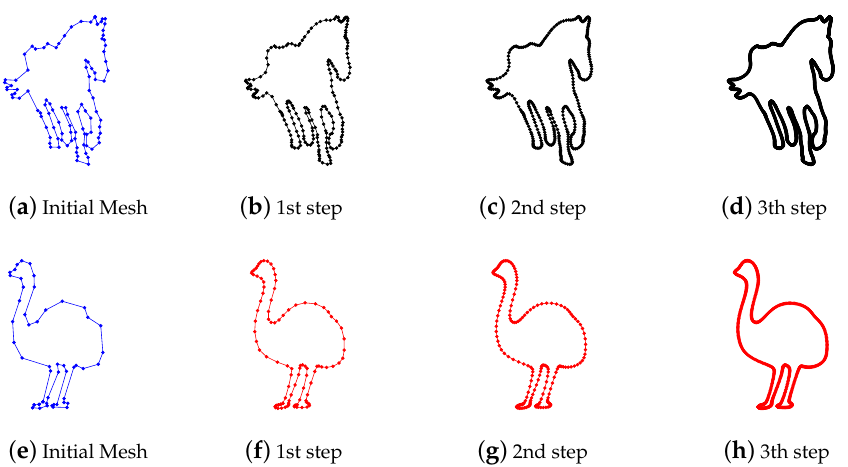
Figure 2. Tree steps of subdivision curves by application of a generalized subdivision scheme of order 3 (black) and 4